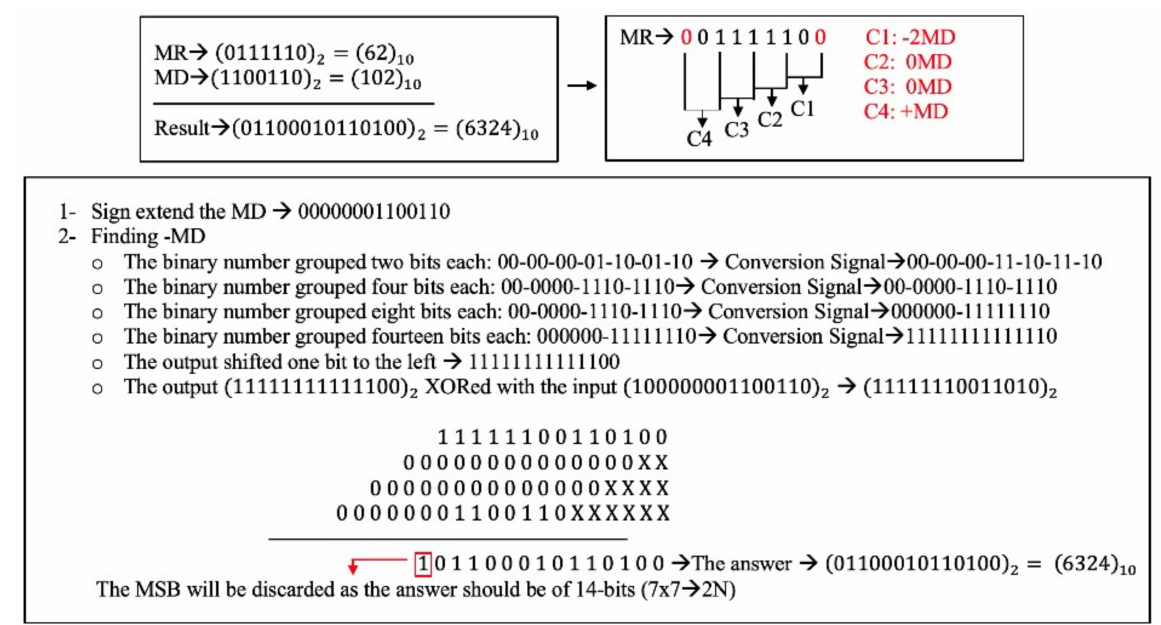
Figure 5. Multiplication of two unsigned numbers using Radix-4 modified Booth algorithm.